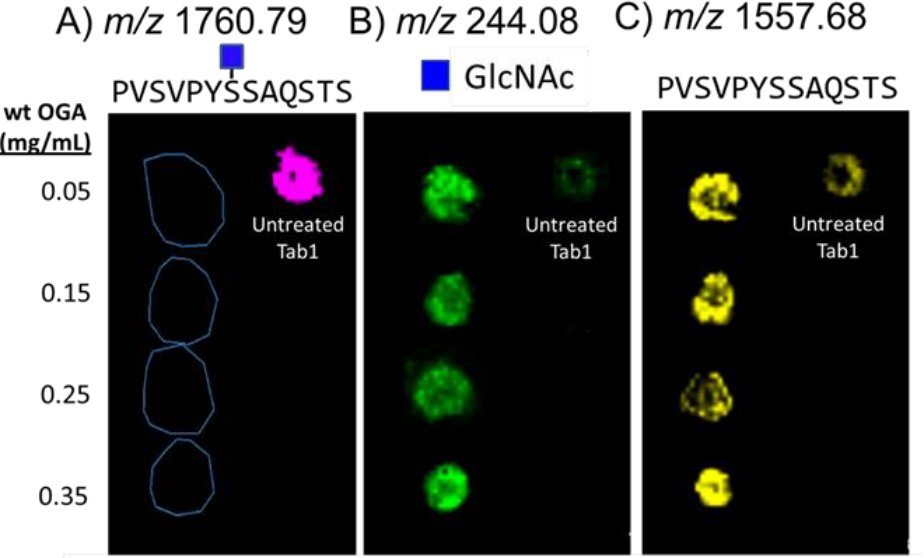
Figure 2. MALDI-MS maps showing the composition of five spots after deposition of O-GlcNAc- modified TAB1 glycopeptide on a slide and treatment with OGA. The extracted ion signals correspond to; ( A ) sodium-cationized glycopeptide ( m/z 1760.79), ( B ) sodium-cationized GlcNAc ( m/z 244.08), and ( C ) sodium-cationized non-glycosylated peptide ( m/z 1557.68). The spot on the right side of each panel is a spot of the glycopeptide that had not been treated with OGA. The four spots on the left side of each panel indicate OGA treatment using four different concentrations of OGA, followed by incubation for two hours.